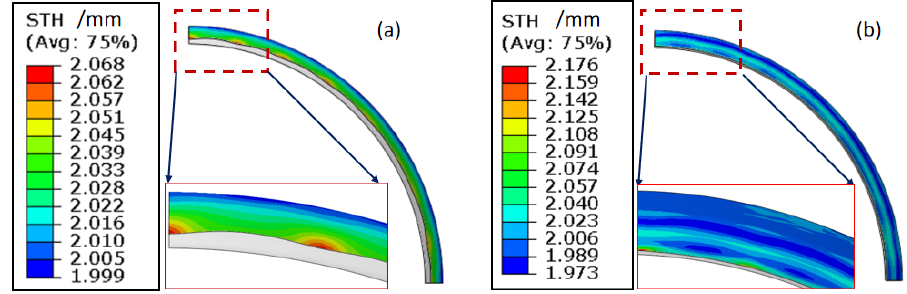
Figure 13. The influence of the external pressure on the instability height.